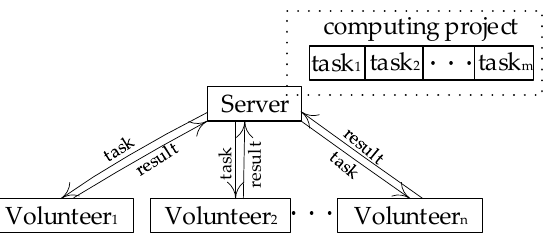
Figure 1. Master-slave model.